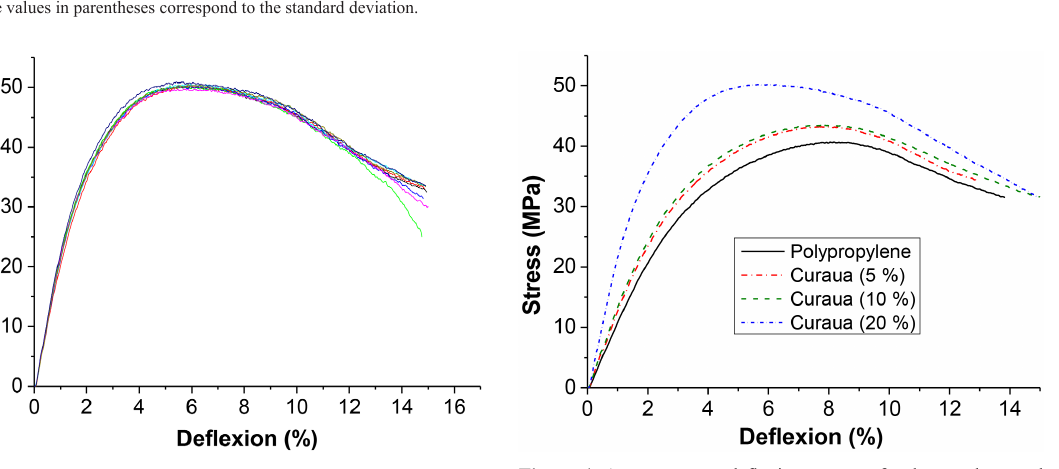
Figure 3. Stress deflexion curves of biocomposite with 20% of curaua fiber.